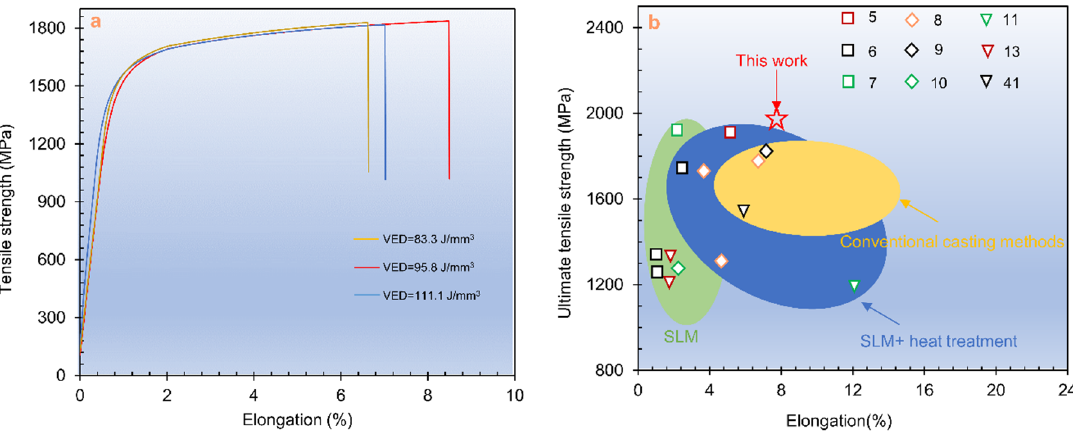
Figure 6. ( a ) Tensile stress–strain curves of SLMed H13; ( b ) Comparison of tensile strength of the H13 specimens manufactured by different techniques, including conventional casting methods, SLM, SLM + heat treatment. Table 2. Mechanical properties of the SLMed H13 samples under different conditions.